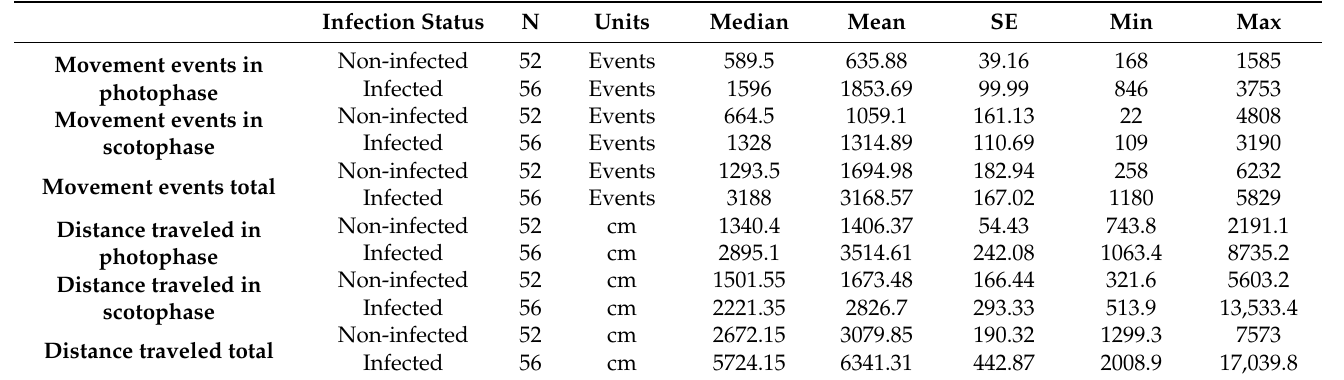
Table 2. Summary values of movement events and distance traveled by non-infected and infected Triatoma infestans .